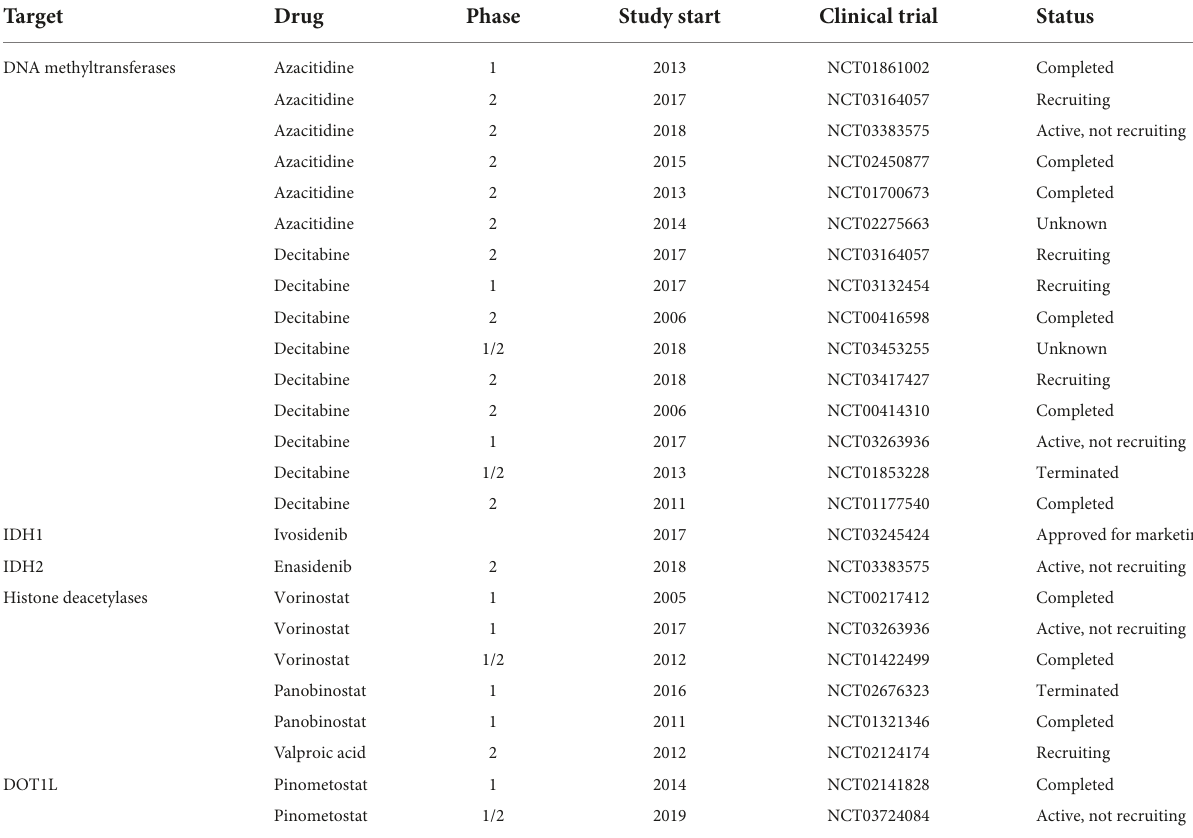
TABLE 2 Clinical trials of epigenetic targeted therapies in pediatric